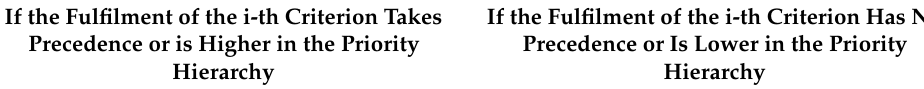
Table 1. Values that define the relationship between criteria.